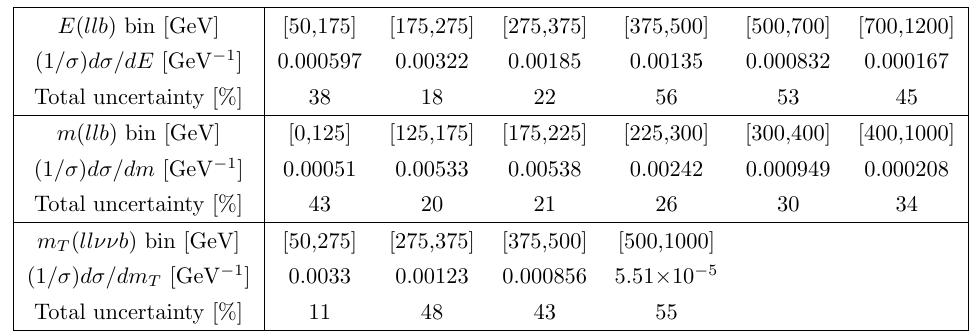
Table 1 . Summary of the measured normalised di(cid:11)erential cross-sections as in [35], with uncer- tainties shown as